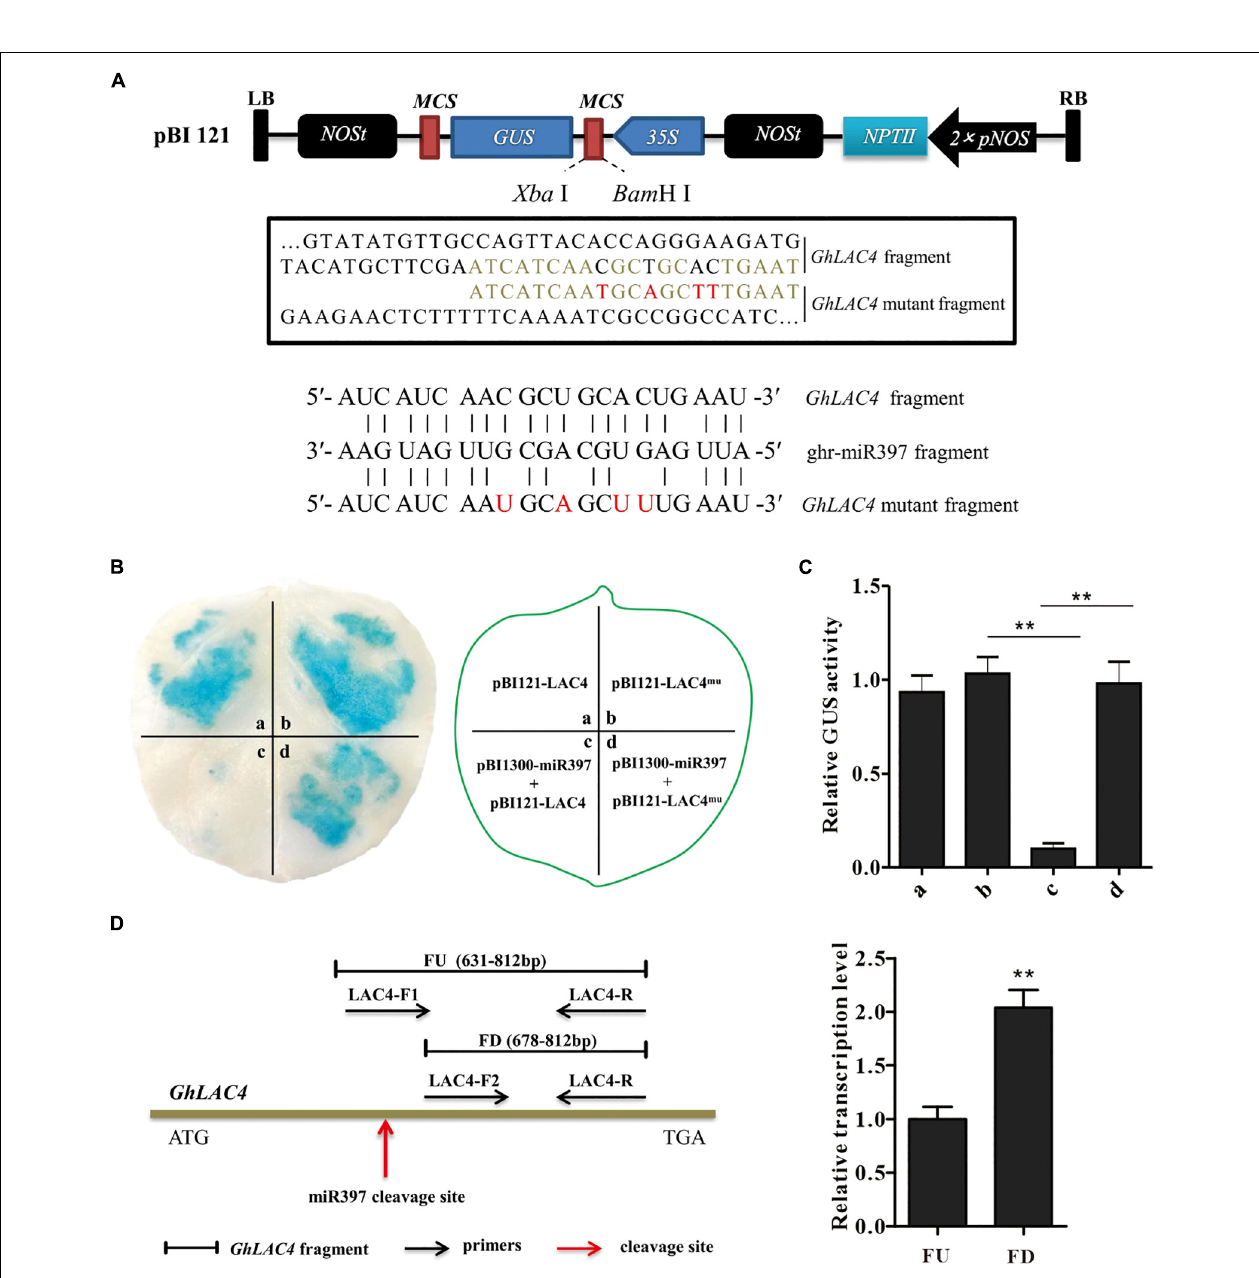
FIGURE 2 | ghr-miR397 regulates the expression of GhLAC4 through post-transcriptional processing. (A) Schematic diagram of pBI121-LAC4 and pBI121-LAC4 mutant. Red letters represent the mutated bases. (B) GUS tissue staining leaf spots (left panel) infiltrated with different vectors as indicated (right panel). (C) Quantitative analysis of GUS activities of different leaf sports corresponding to (B) with the 4-MU assay. The GUS activity value of at a site is arbitrarily designated as ‘1.’ (D) qPCR analysis of ghr-miR397-directed cleavage of GhLAC4 mRNA. Illustration of the primers designed (left panel), fragments FD and FU represent PCR amplification products located downstream of and containing the cleavage site, respectively (right panel). Mean with SD comes from triple repeats experiments. Significant differences in (C,D) were determined using Student’s t -test ( **P < 0.01).